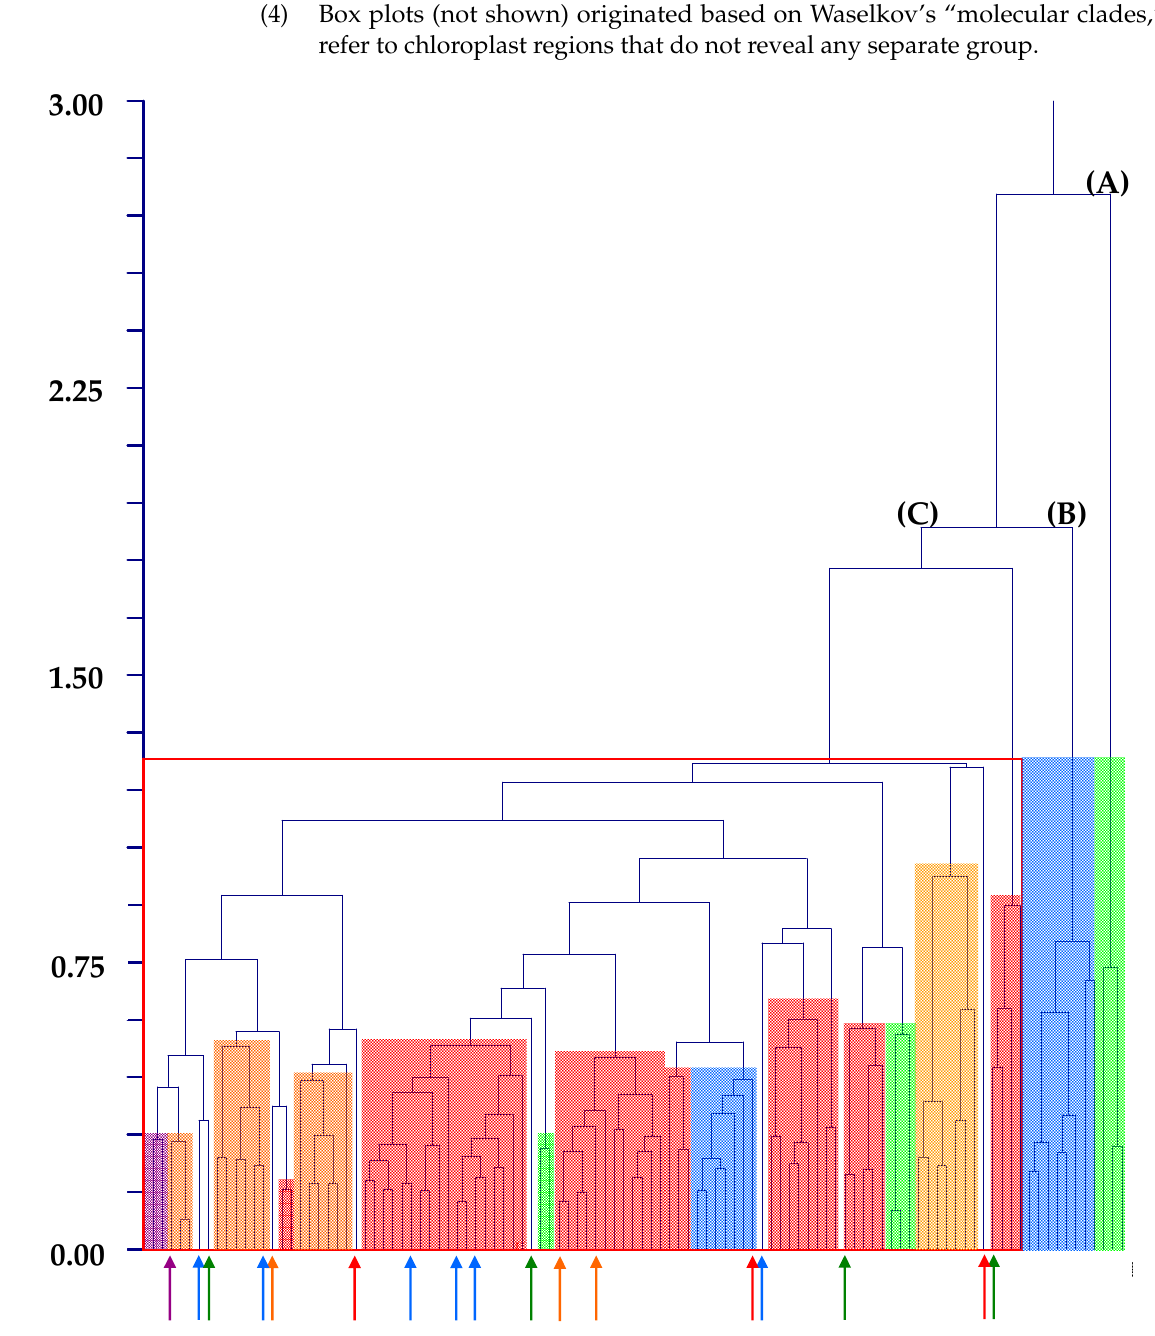
Figure 3. Dendrogram graph (hierarchical clustering, UPGMA method) of “molecular clades” sensu Waselkov et al. [15] (pag. 446, Figure 1A). Main clades: (A) = Galápagos -clade (light green); (B) = South American -clade (blue); (C) = residual-group (square with red sides); Hybridus -clade in red, Eurasian/South African/Australian (ESA)-clade in orange, Dioecious/Pumilus -clade in violet. Arrows indicate single samples of the various clades (colors are the same as those indicated in this caption), which are included in different clades or form isolated lineages.